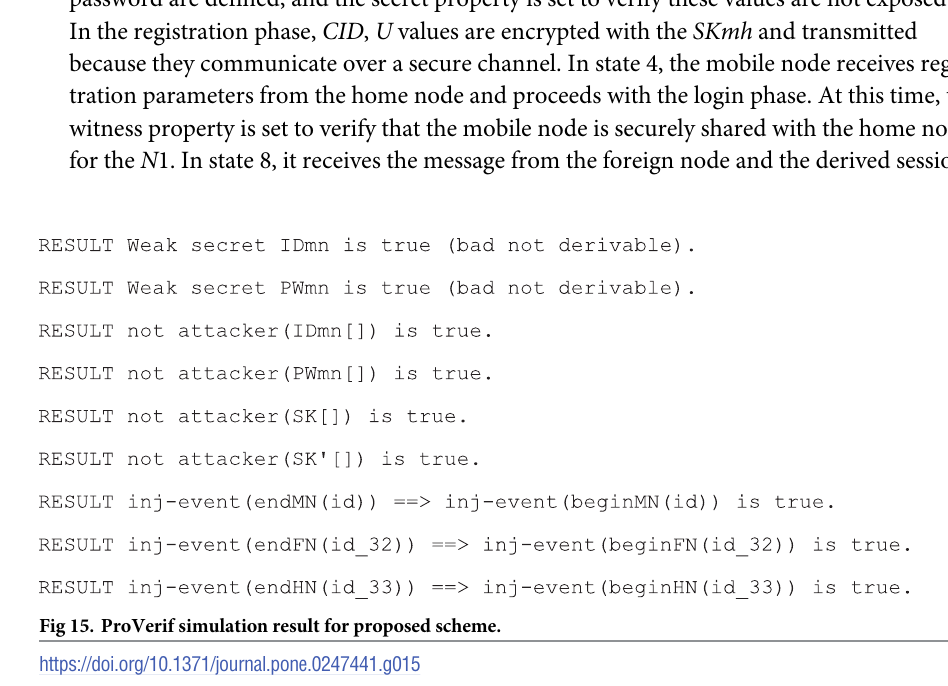
Fig 15. ProVerif simulation result for proposed